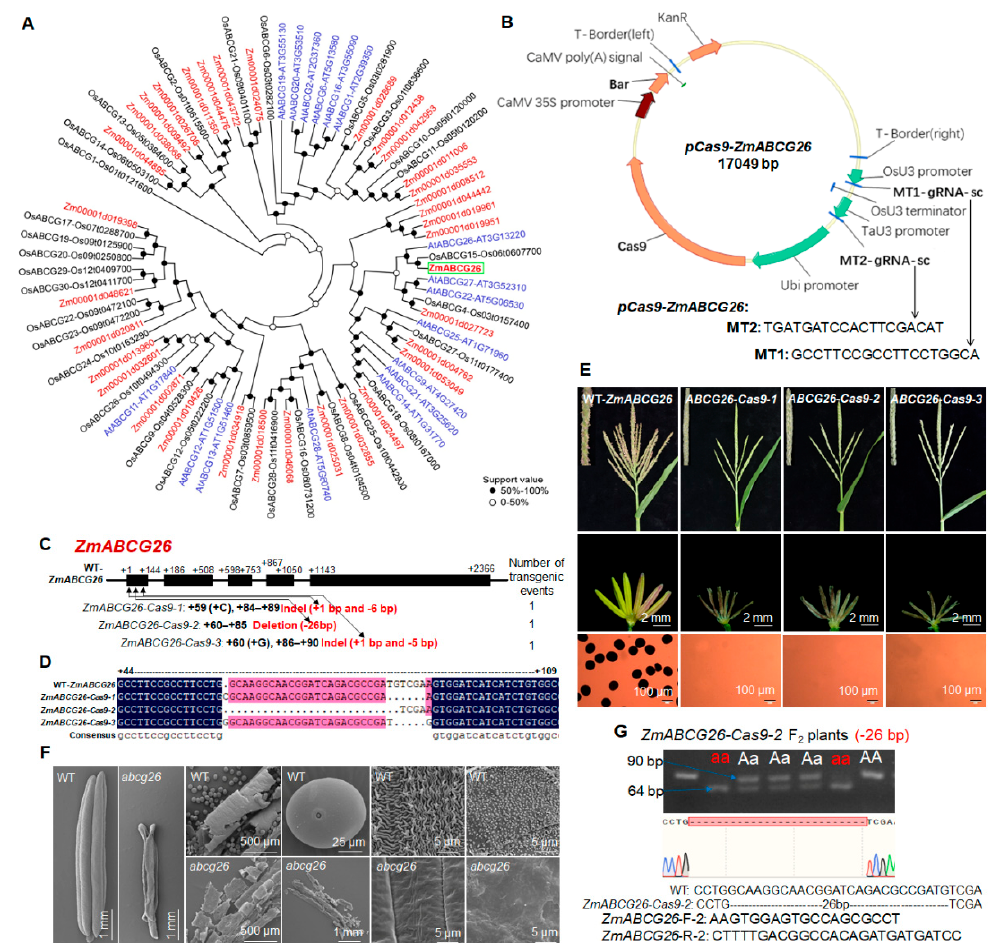
Figure 2. Phylogenetic tree of WBC/ABCG family members, phenotypic characterization, sequencing analysis, and cosegregating molecular marker development of CRISPR/Cas9-induced ZmABCG26 male-sterile mutants: ( A ) phylogenetic tree of the WBC/ABCG family members in Arabidopsis (At), rice (Os), and maize (Zm). A neighbor-joining tree showed the evolutionary relationships of WBC/ABCG members in the three species; ( B ) physical map of pCas9-ZmABCG26 construct carrying two gRNAs and the information of target sites in ZmABCG26 ; ( C ) gene structure of ZmABCG26 and mutation analysis of three knock-out lines ( ZmABCG26-Cas9-1 , -2 , and -3 ) created by the CRISPR/Cas9 technology; ( D ) DNA sequencing of targeted mutation sites or fragments among WT and the three knockout lines; ( E ) comparison of tassels, anthers, and pollen grains stained with I 2 -KI among WT and the three knockout lines; ( F ) SEM analysis of the whole anthers, pollen grains, anther outer and inner surfaces in WT and one abcg26 mutant at anther developmental stage 13; ( G ) development of cosegregating molecular markers for genotyping ZmABCG26-Cas9-2 mutation in F 2 plants. T 0 plants did not produce seeds by self-pollination, and maize inbred line Zheng58 was used as a male parent to pollinate plants. To avoid the complications from the